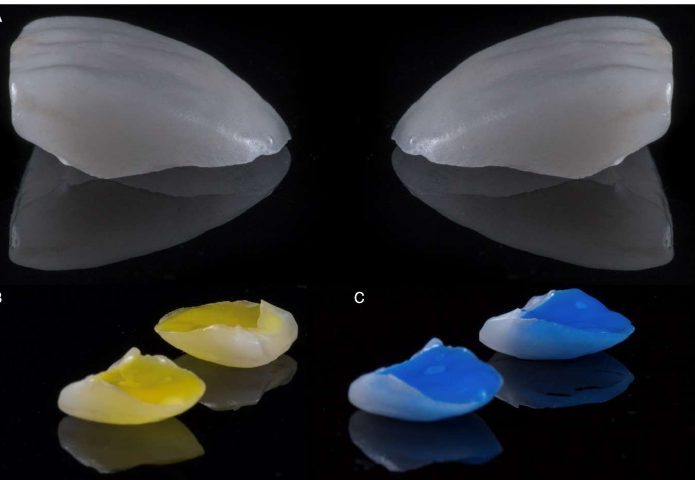
Figure 6. Intaglio surface ceramics treatment. ( A ) Indirect restorations prior to surface treatment. ( B ) Hydrofluoric acid treatment. ( C ) Phosphoric acid treatment. Total isolation was provided with a rubber dam (Dental Dam, Nic Tone) covering the maxillary anterior region and retained with claps (Clamp 2, Hu-Friedy). The central inci- sors also received clamps (Clamp 212, Hu-Friedy) along the gingival contours, and the teeth were treated first with 37% phosphoric acid (Total Etch, Ivoclar Vivadent, Schaan, Liechtenstein) for 15 s and gently air dried, followed by primer application (Primer Opti- bond FL, Kerr, Orange, CA, USA), and excess was gently removed. Then, adhesive (Adhesive Optibond, FL Kerr, Orange, CA, USA) was applied, and the ceramic restorations were cemented with light shade resin cement (Variolink Esthetic LC, Ivoclar Vivadent, Schaan, Liechtenstein). Excess cement was removed, and each res- toration received an initial tack cure within 5 s. Additional excess cement was removed with floss, and the final light-cure was provided with 20 s on the facial surface, 20 s on the mesial, and 20 on the distal surface (Figure 7).